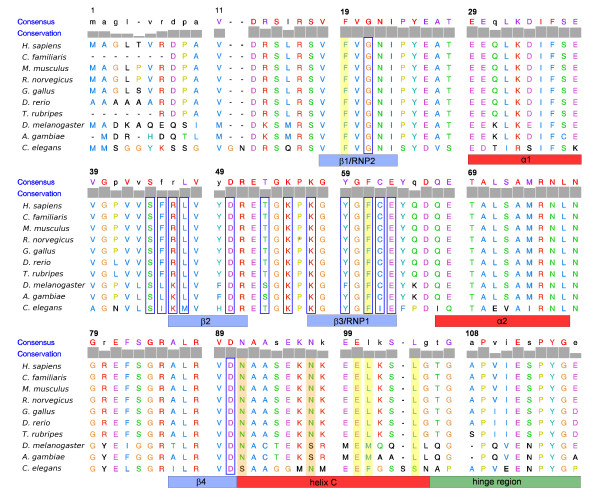
Multiple alignment of CstF-64 N-terminal RRM and helix C region. Colors: blue = β-strands; red = α-helix; green = hinge region (partial); yellow shaded = helix C stabilizing interactions [22]; boxed blue = residues most affected by RNA binding, according to NMR relaxation [23].